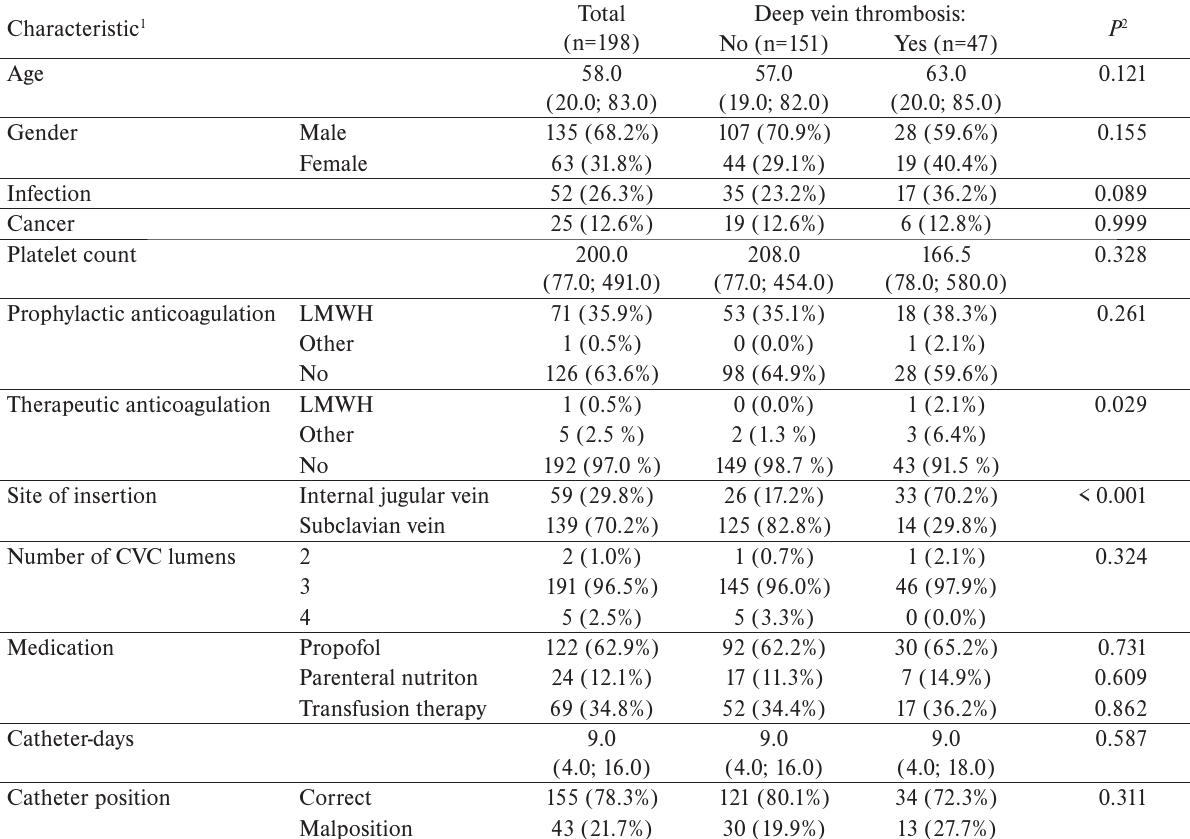
Table 5. Characteristics of study